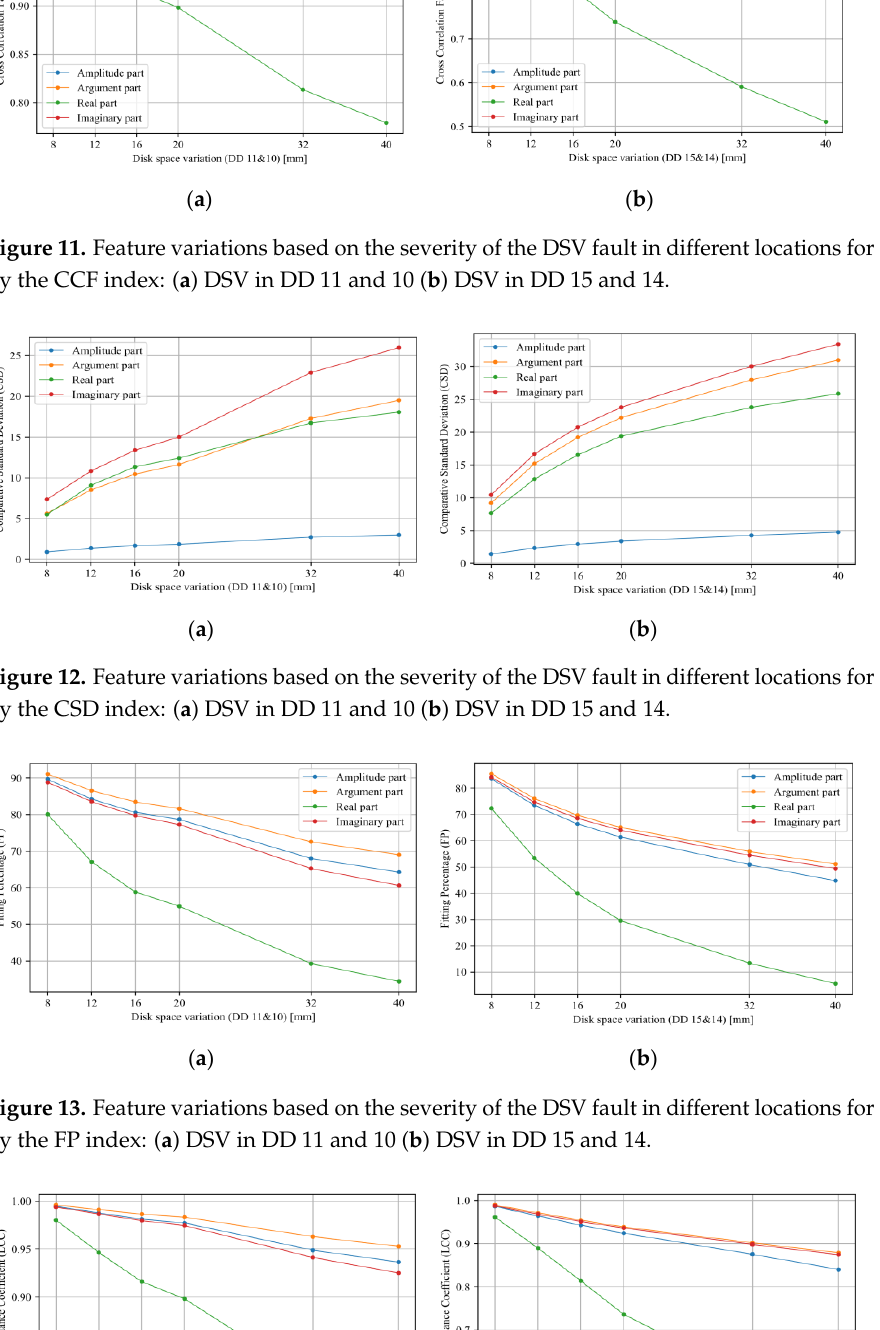
( b ) Figure 15. Feature variations based on the severity of the DSV fault in different locations for ex- tracted by the NRMSD index: ( a ) DSV in DD 11 and 10 ( b ) DSV in DD 15 and 14. ( a ) ( b ) Figure 16. Feature variations based on the severity of the DSV fault in different locations for ex- tracted by the SD index: ( a ) DSV in DD 11 and 10 ( b ) DSV in DD 15 and 14.